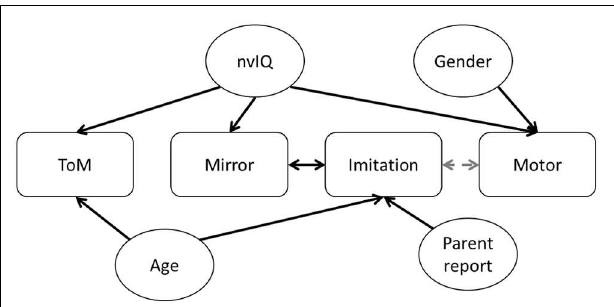
domain performance without any age, gender or IQ